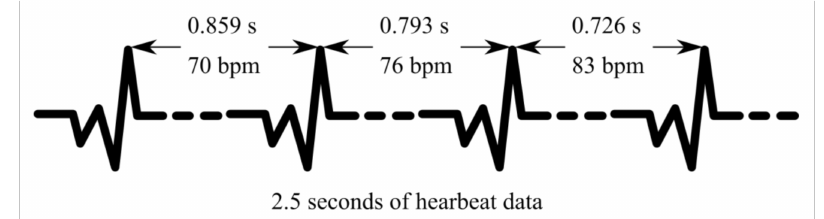
Figure 1. The representation of heart rate variability (HRV), where the peaks mark the heartbeats and the time between them. Source: www.heartmath.com / science /